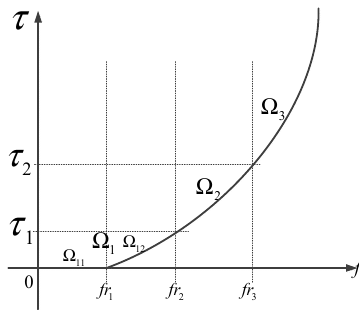
Figure 4. Relation between attack rate and time delay.